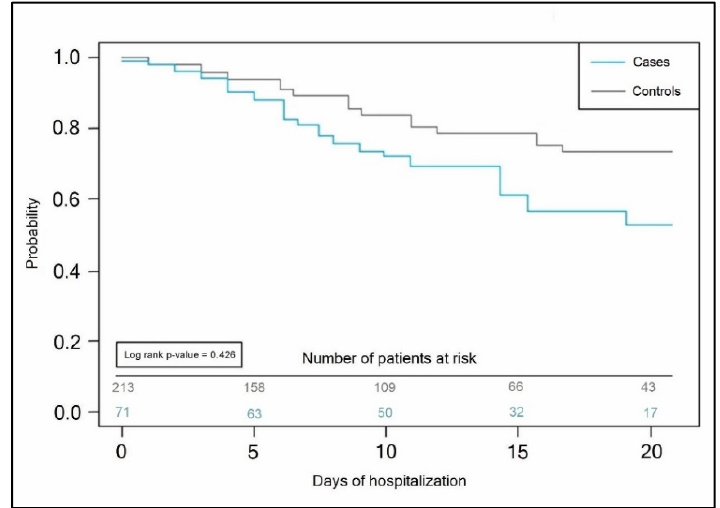
Figure 2. Kaplan–Meier probability curve of survival after ICU admission between patients of Roma ethnicity and the general population.